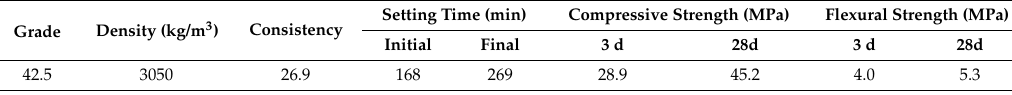
Table 2. The physical and mechanical properties of cement.